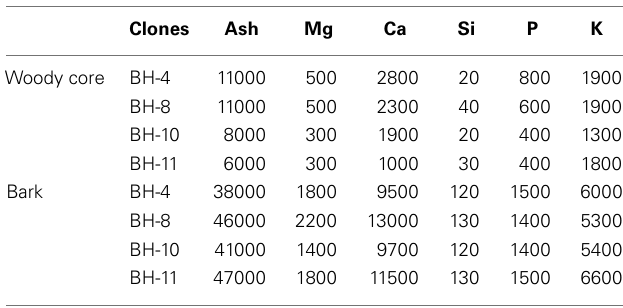
Table 5 | Composition of ashes on wood and bark (unit: mg/kg of